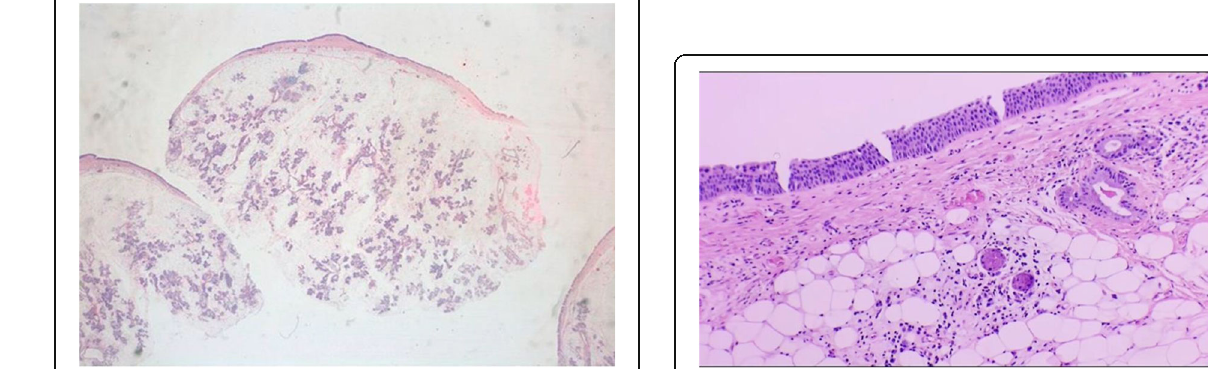
Fig. 3 A lipomatous tumour lined by respiratory cylindric epithelial cells, bronchial type. (H&E.